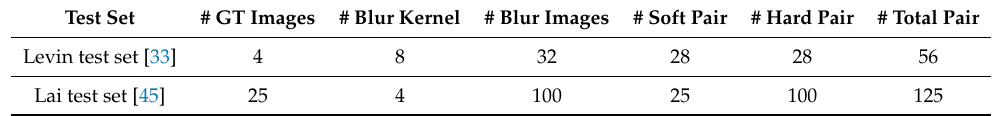
Table 3. Configurations of Levin test set [33] and Lai test set